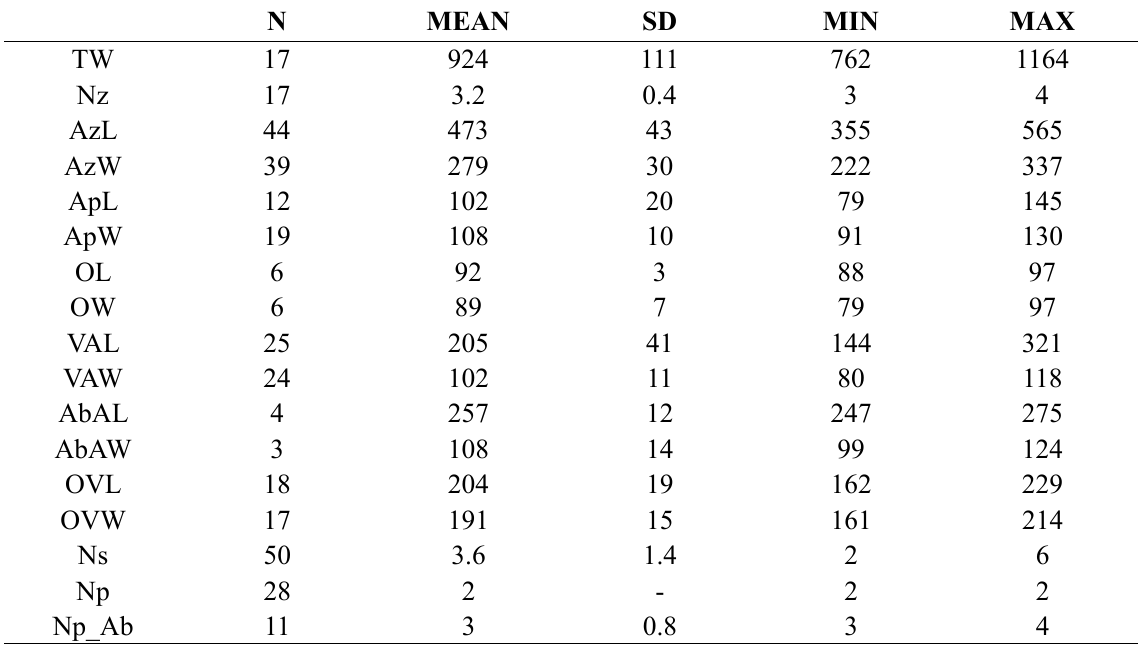
Table 2. Measurements of Schizoretepora solanderia (Risso,